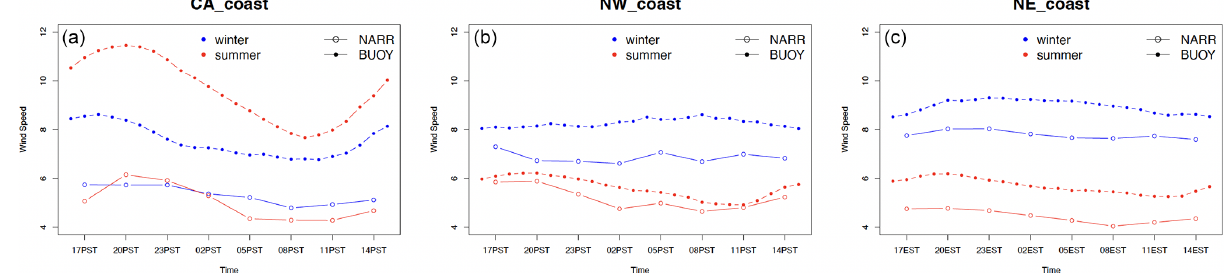
Figure 3. Diurnal wind speed pattern of NARR and buoy wind data for the three offshore locations on the CA coast, NW coast, and NE coast (from left to right), displayed in winter (blue) and summer (red). Diurnal cycles are computed as averages over 10 years (1995–2004).